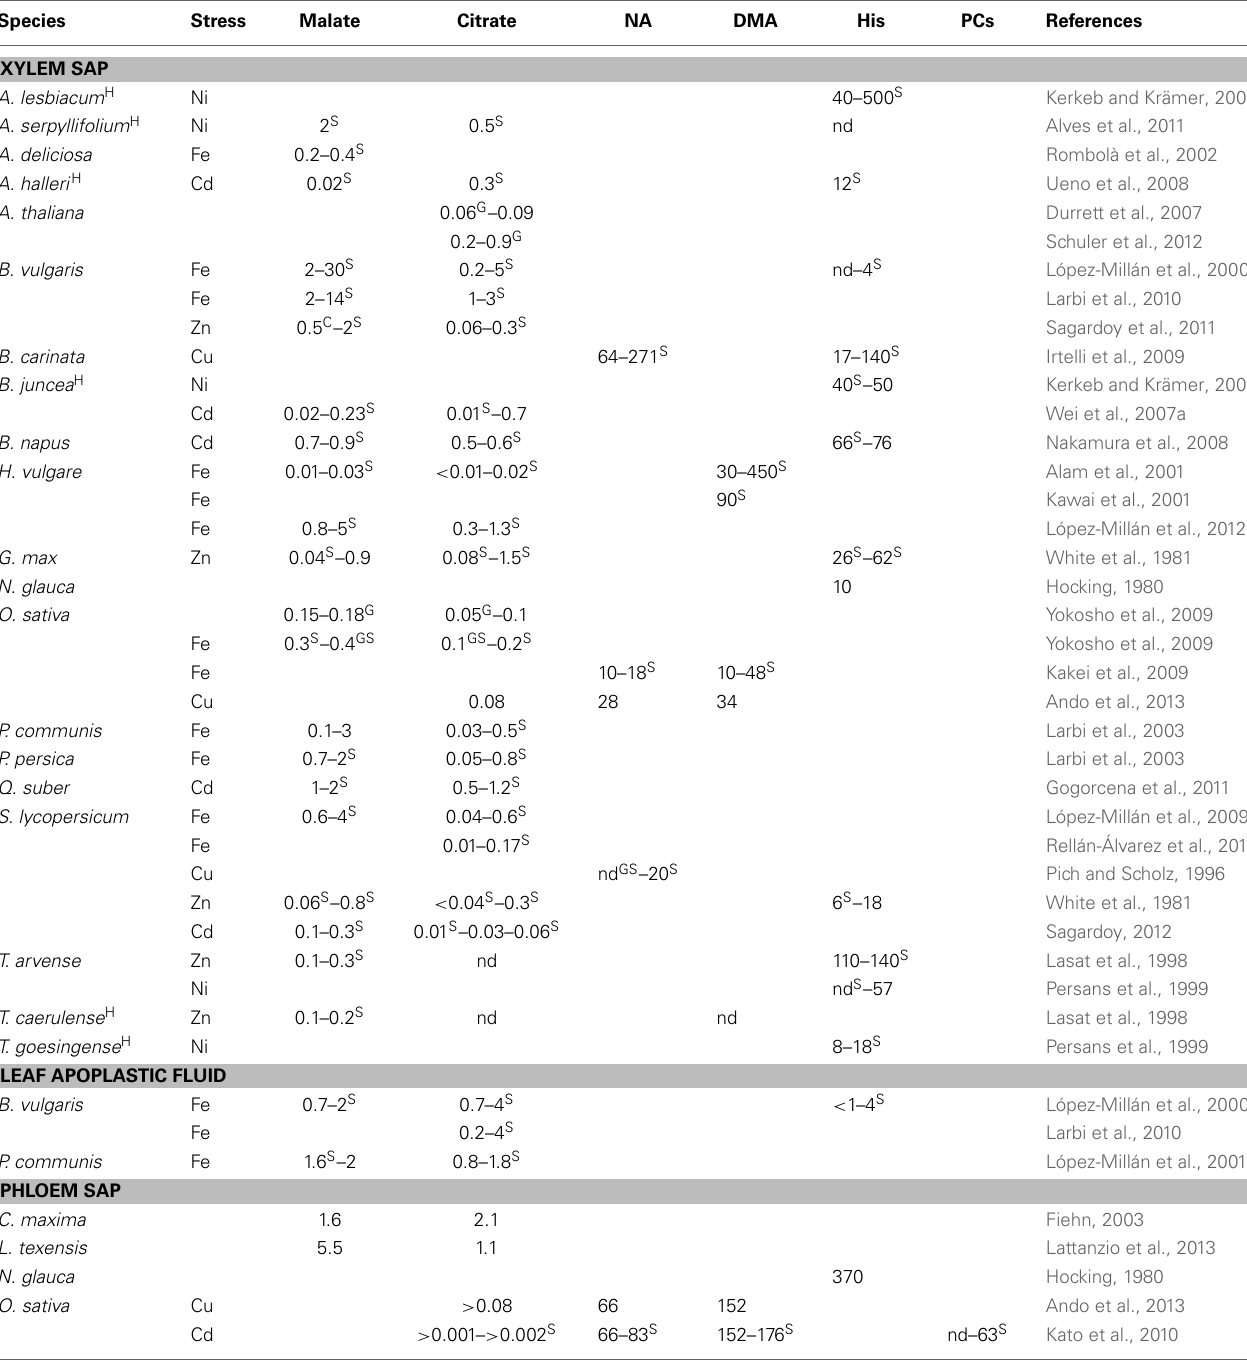
Table 2 | Metal ligand concentrations (malate and citrate in mM and the rest in μ M) in xylem sap, leaf apoplastic fluid and phloem sap.